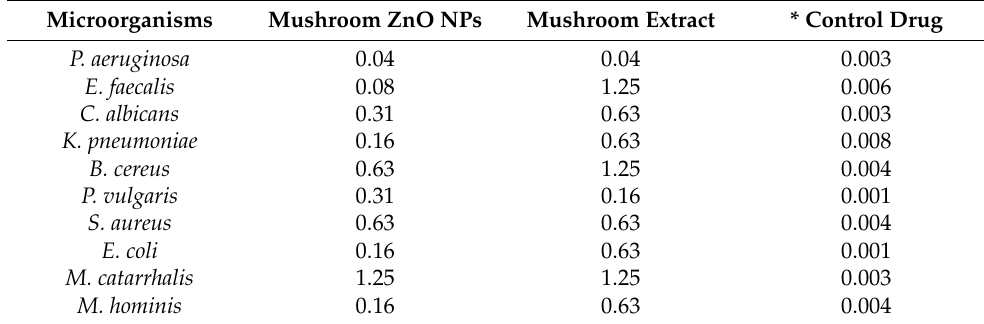
Antimicrobial activity of mushroom ZnO NPs (MIC in mg/mL) against selected pathogenic